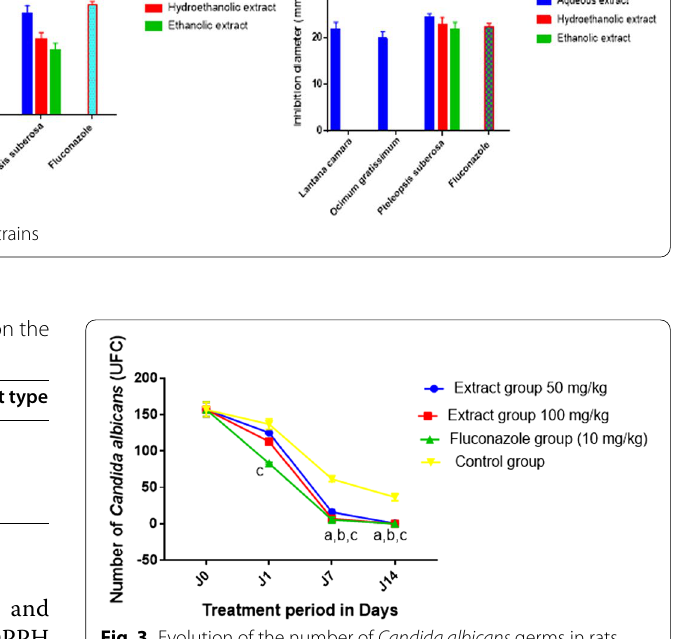
Fig. 3 Evolution of the number of Candida albicans germs in rats during of the treatment. The letters (a: extract group 50 mg/kg; b: extract group 100 mg/kg; and c: fluconazole) marked following the period of the treatment reflect a significant different between these groups and the control